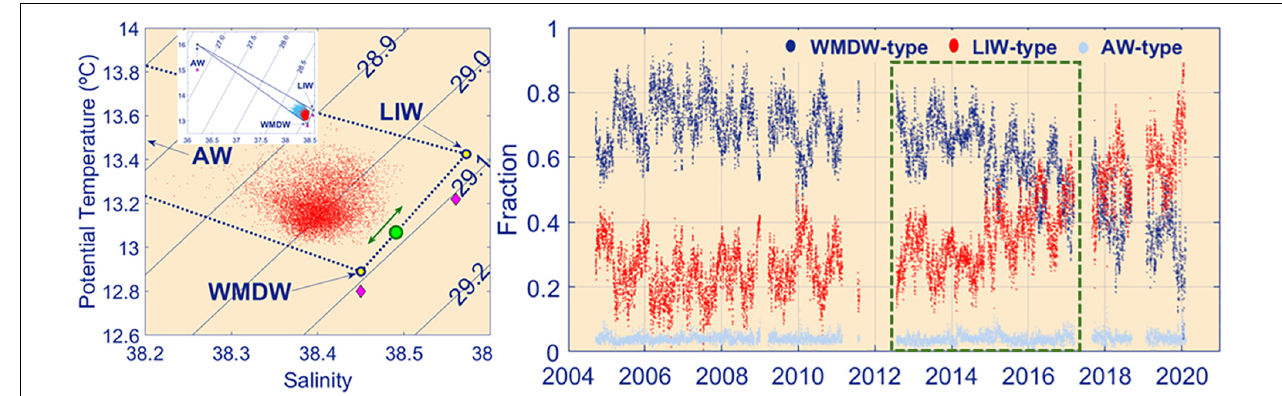
FIGURE 9 | Left panel: θ − S diagram of the θ -minimum samples. Circles indicate the triplet of reference used for the fraction decomposition. The inset is the θ - S diagram for all (light blue dots) and θ -minimum (red dots) samples, included to show that all samples lay inside the triangle defined by the triplet. Magenta diamonds are the points used in García Lafuente et al. (2007). Green circle and the arrow represent a hypothetical evolution of WMDW-type along the line joining the initial WMDW and LIW that would change the initial triplet (see text for more explanations). Right panel: time evolution of the fraction of the different waters using the triplet initially defined. Dashed green rectangle embraces the period of available biogeochemical